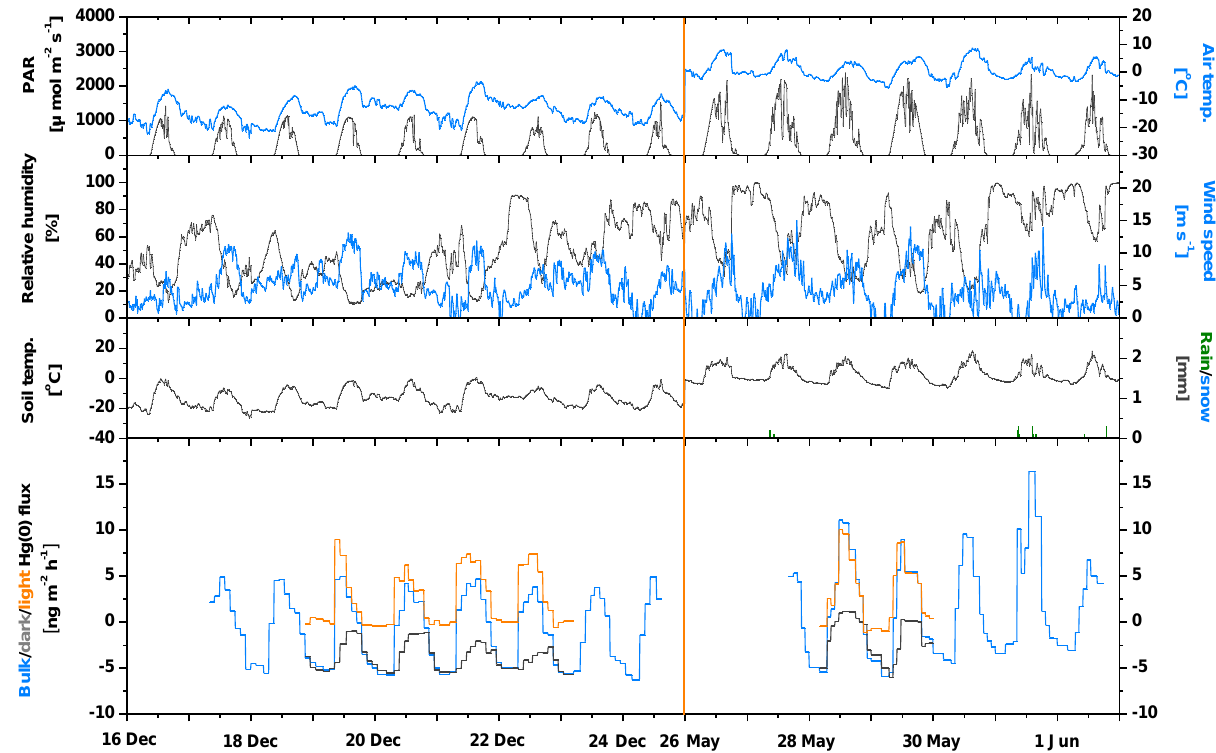
Figure 7. Temporal variation in bulk Hg(0) flux in the light, Hg(0) flux in the dark, and net Hg(0) flux in the light (bulk Hg(0) flux in the light–Hg(0) flux in the dark) in six study days without precipitation during the December 2014 campaign and May–June 2015